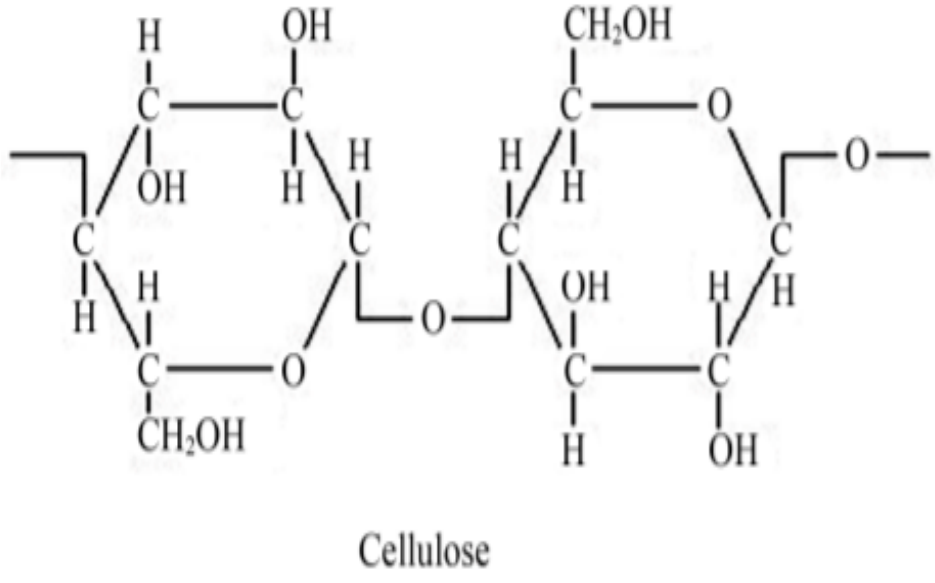
Figure 1. Structure of cellulose [79].